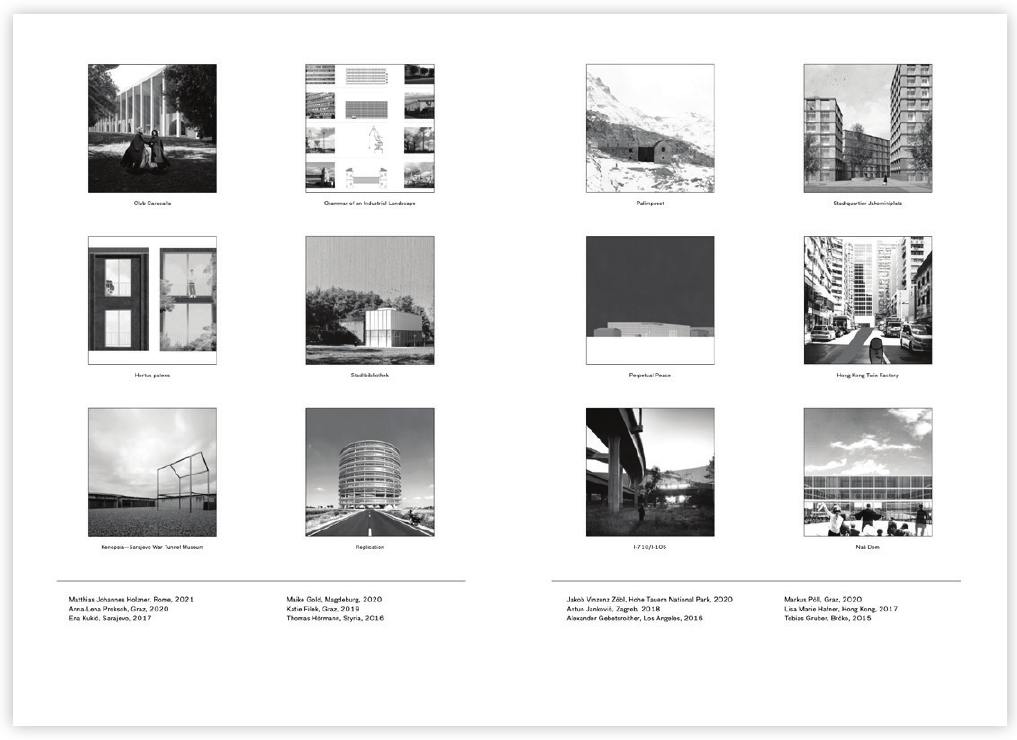
Figure 4. Index of Masters Th eses examples in Th inking Design appended booklet.